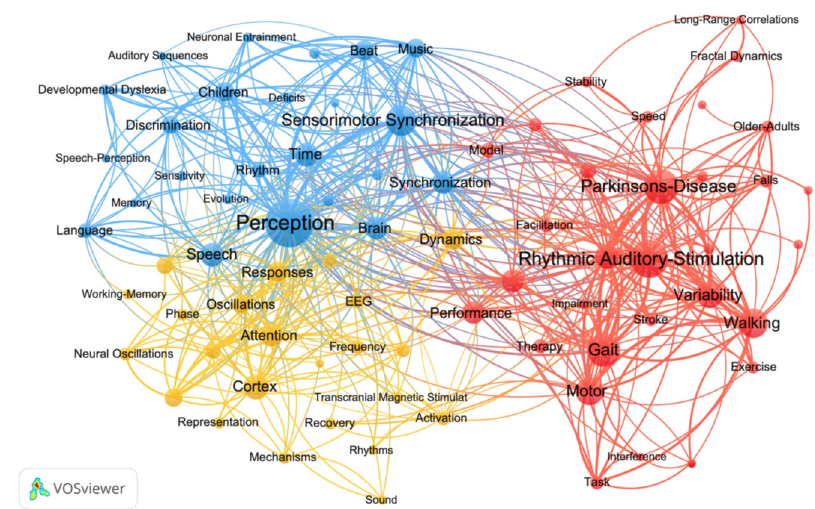
Figure 4. Visualization of the keywords co-occurrence analysis on rhythmic auditory stimulation research. Alt text: A clustering graph is plotting the research topics within rhythmic auditory stimulation research. There are three themes: motor dysfunction, cognition, and perception. Table 4. The top 10 most-cited articles during